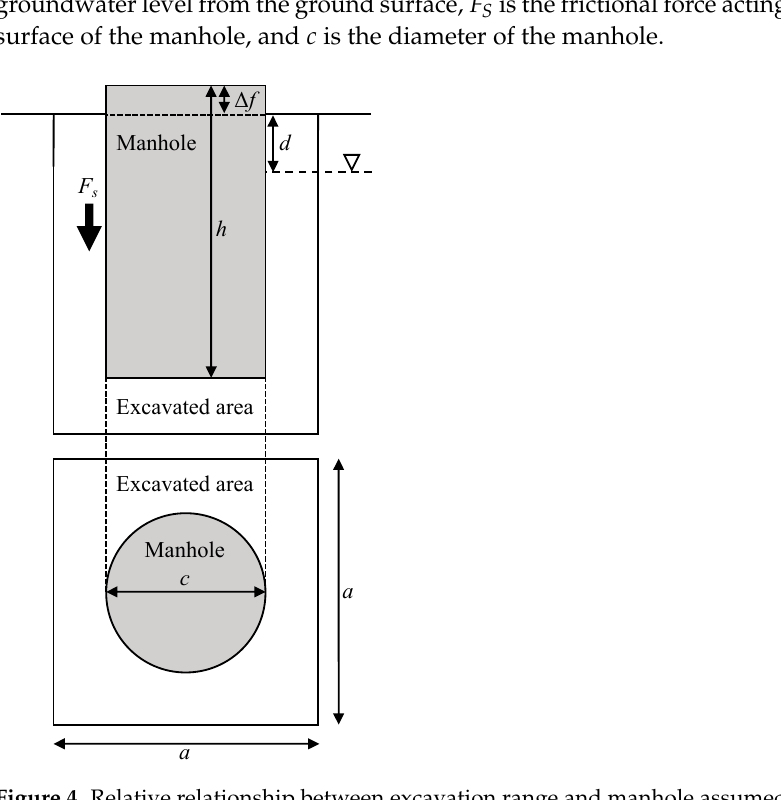
Figure 4. Relative relationship between excavation range and manhole assumed in analysis.